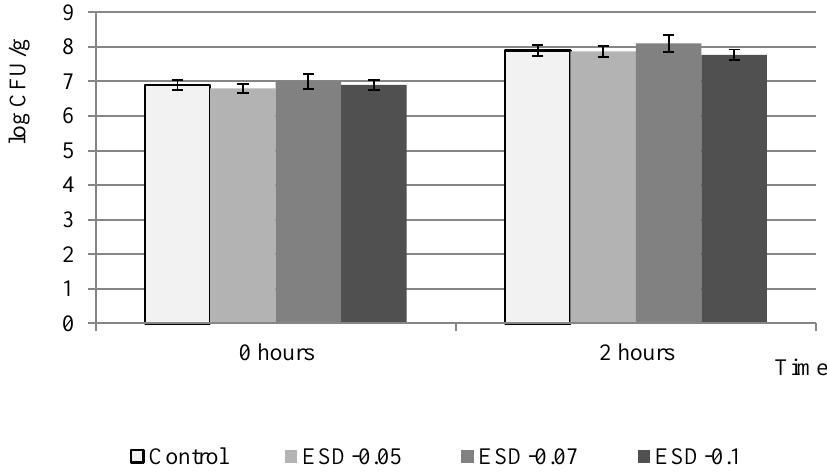
Figure 2. Microbiological counts during fermentation.